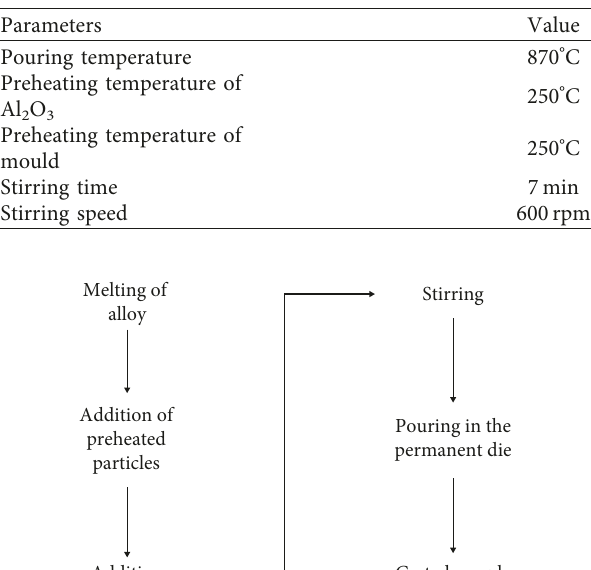
Table 2: Casting variables.